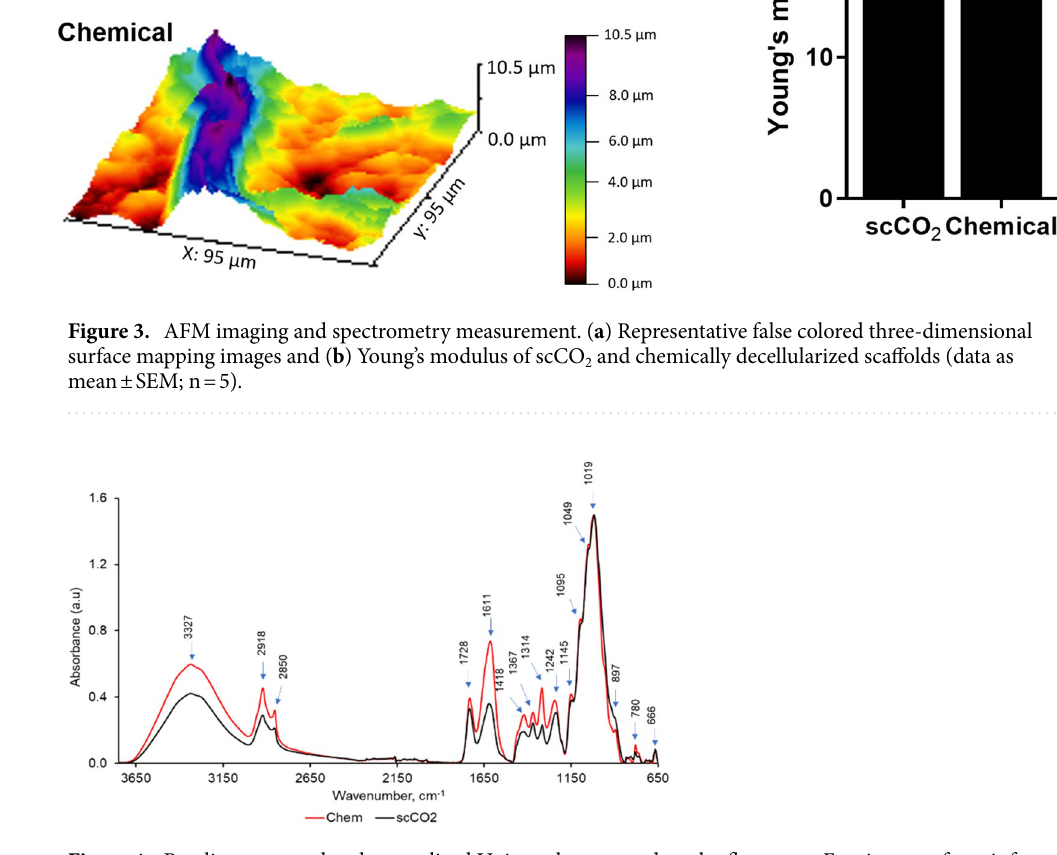
Figure 4. Baseline corrected and normalized Universal attenuated total reflectance - Fourier-transform infrared spectroscopy (UATR-FTIR) spectra acquired from chemically (Chem) and scCO 2 decellularized baby spinach leaf scaffolds (n =